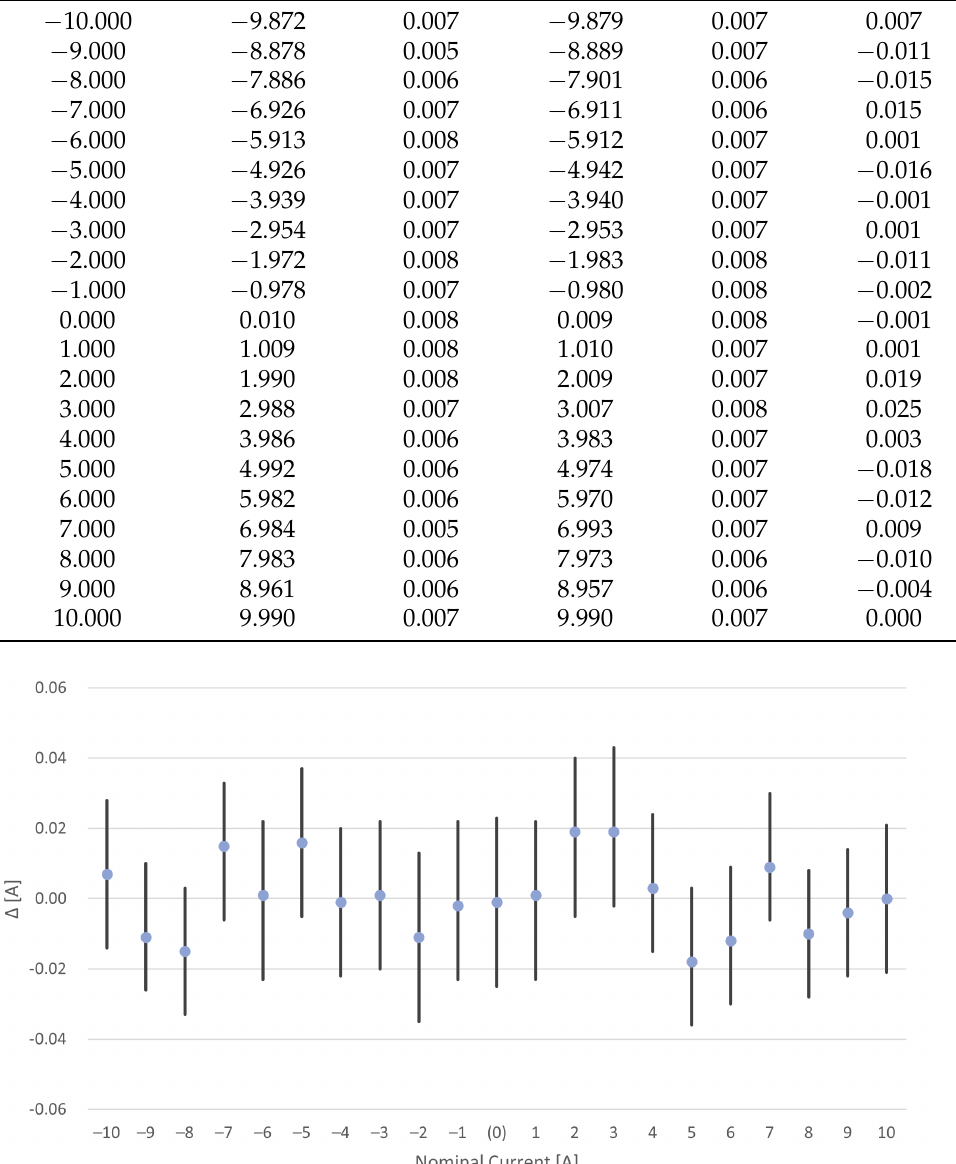
Figure 6. Magnetic hysteresis test. Gain and offset error, equal to − 0.838% and 0.290 A, respectively, were also evaluated and compensated in the successive processing step. The microcontroller (MCU) chosen for the measurement setup is the STM32F4V11VET. The MCU’s characteristics are written below and, for the sake of brevity, just information relevant for the case study are